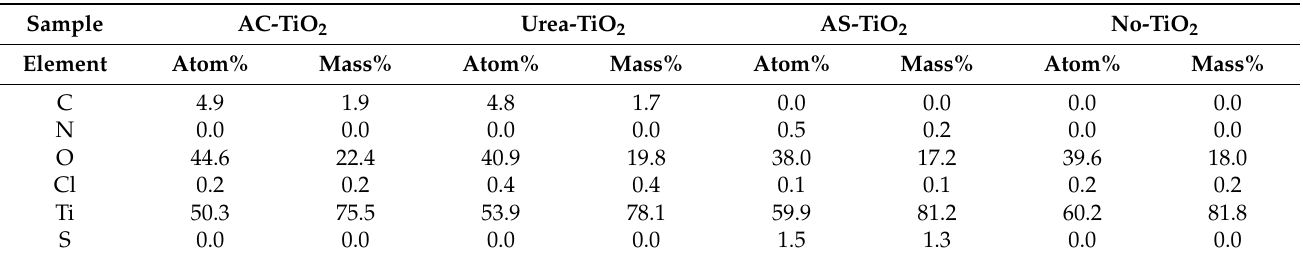
Table 1. EDS analysis of the as-prepared TiO 2